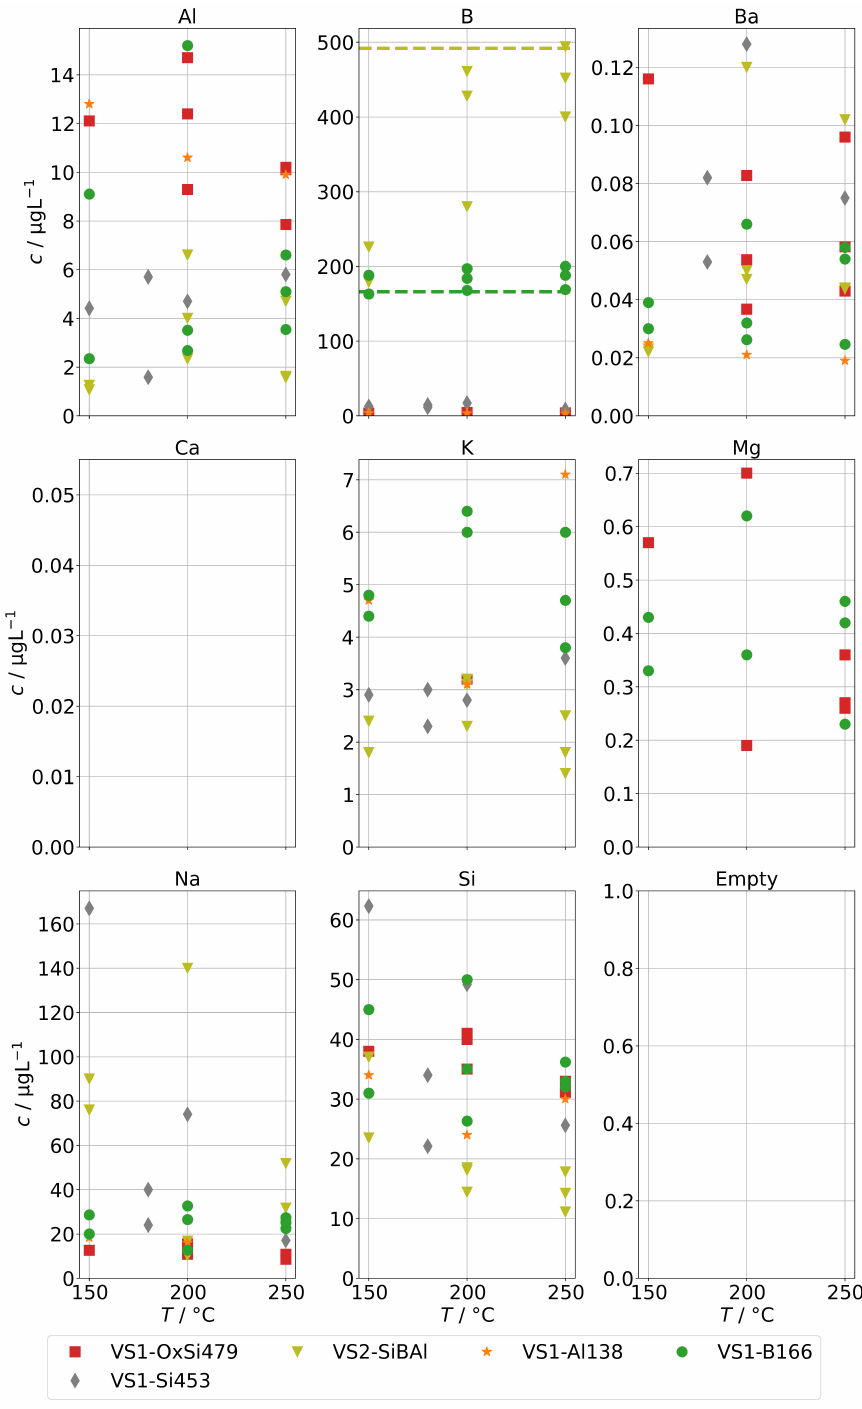
Figure 11. Concentrations of quantifiable species in condensates of the SB-SG obtained with spiked feed-water (group B) in dependence of operation temperature. Dashed lines indicate feed-water concentrations (no concentrations above limit of detection for